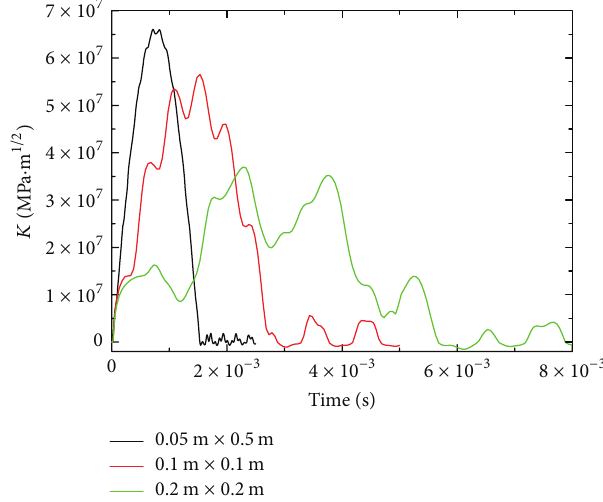
Figure 10: Mode I DSIF curves at node 1 of different plate dimensions with the impact velocity of 5 m/s and crack length of 0.02